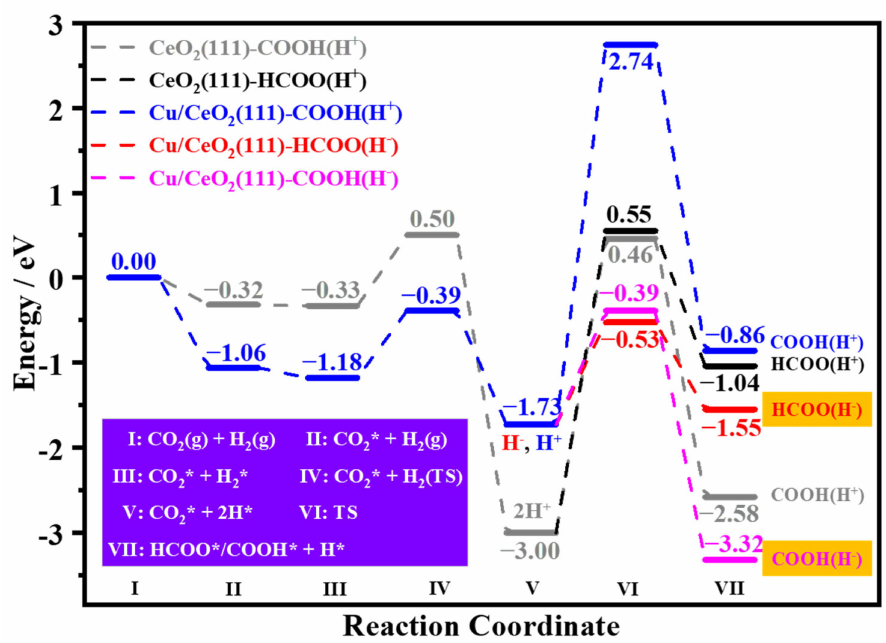
Figure 6. Calculated energy profiles of the first few key steps of the CO 2 hydrogenation reaction on the CeO 2 (111) and Cu/CeO 2 (111) surfaces.